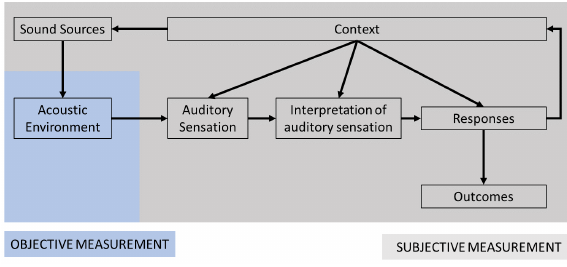
Fig. 1. Soundscape Framework. Adapted from ISO 12913- 1